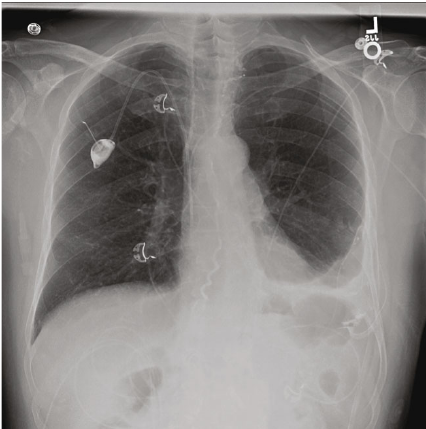
Figure 3: Chest X-ray after thoracic duct lymphangiogram using glue embolization, with resolving chylothorax in the left